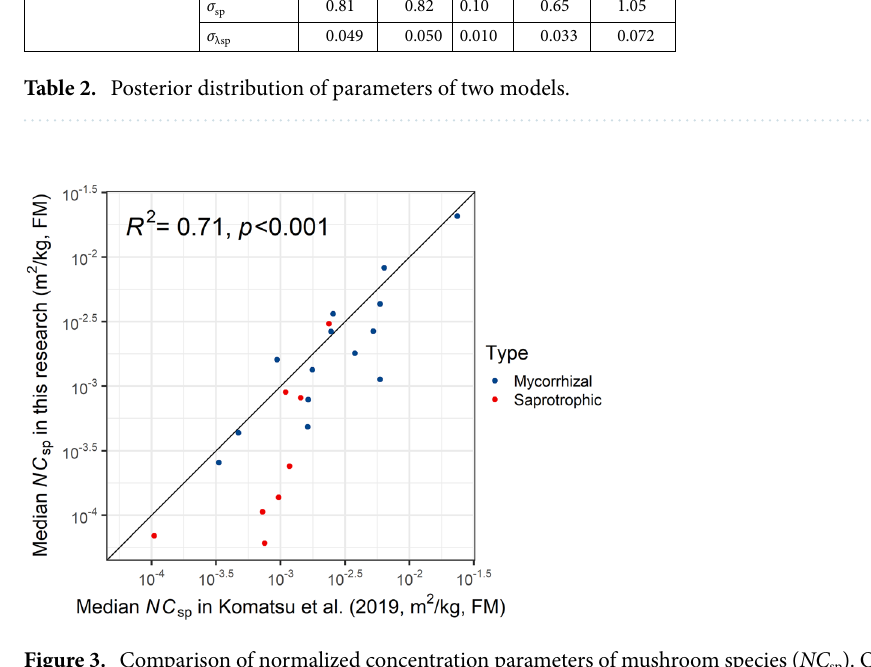
Figure 3. Comparison of normalized concentration parameters of mushroom species ( NC sp ). Only the mushroom species common to Komatsu et al. 22 and in this study were considered. The scales of both axes are logarithmic.